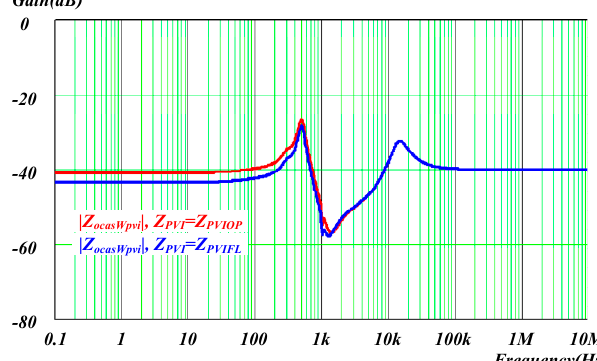
| Z | under di ff erent Z ocasWpvi